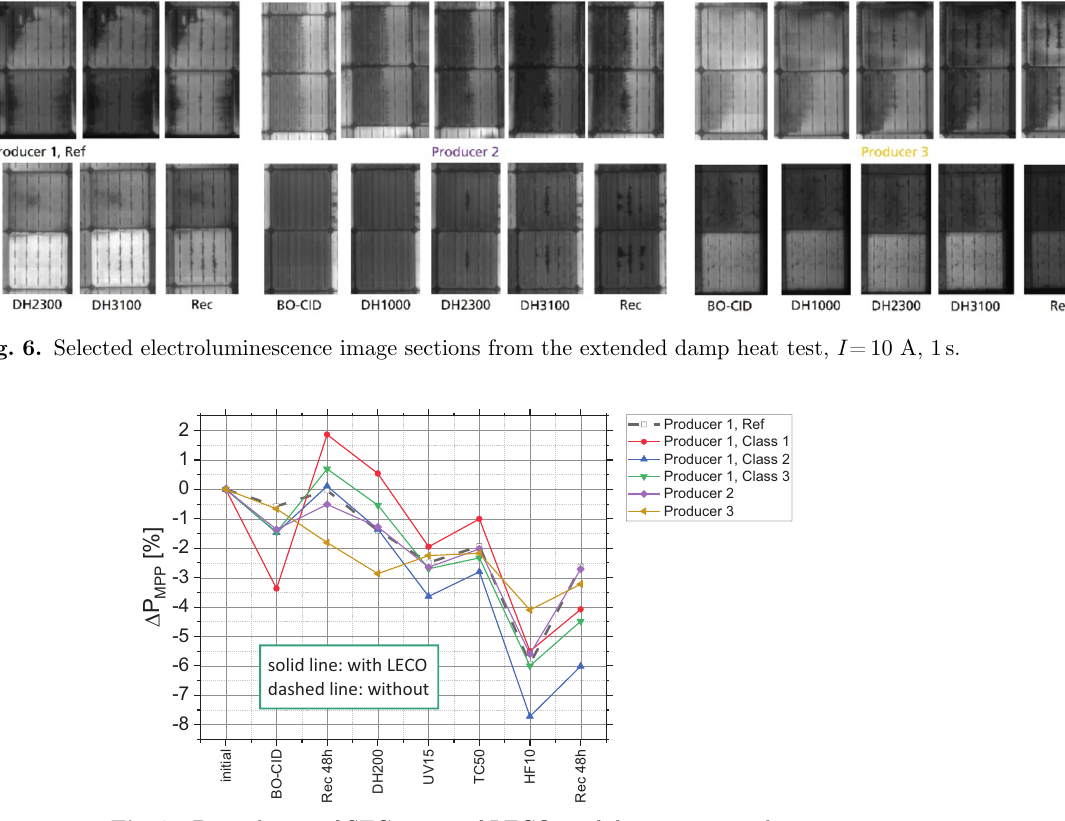
Fig. 7. Degradation of STC power of LECO modules in sequential